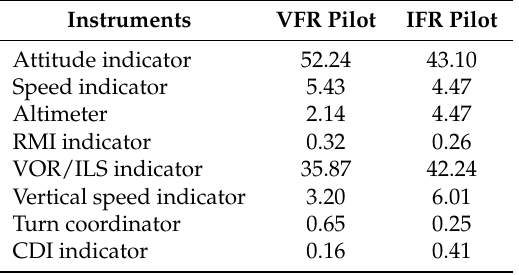
Table 10. Averaged percentage values of attention using the attention gradation